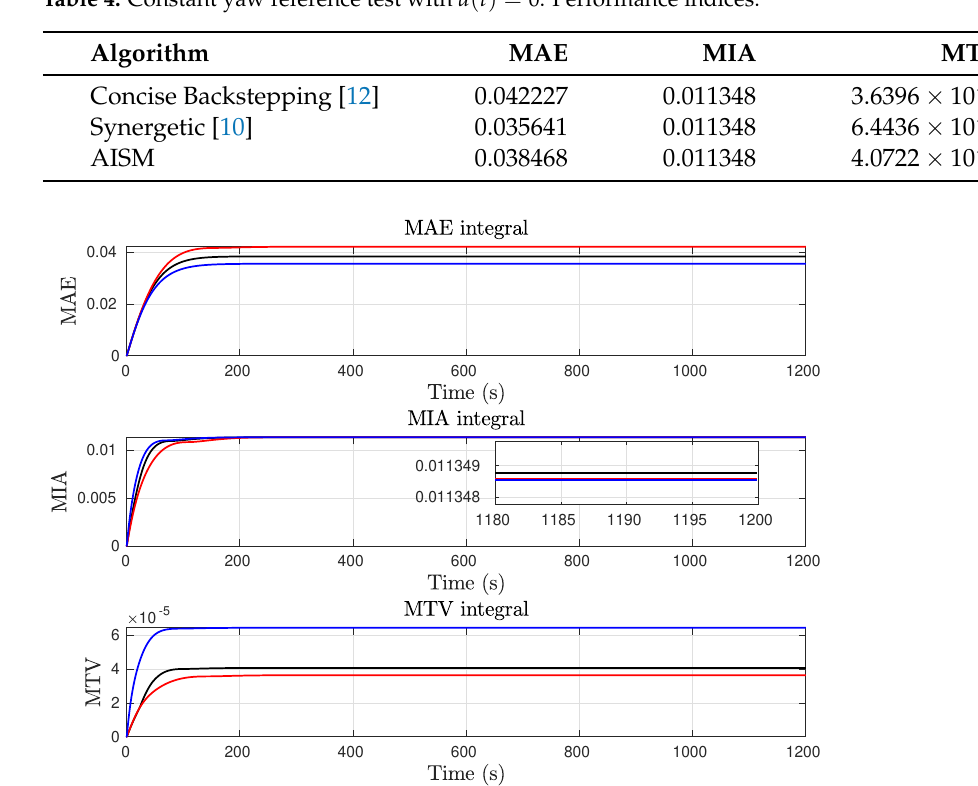
Table 4. Constant yaw reference test with d ( t ) = 0. Performance indices.